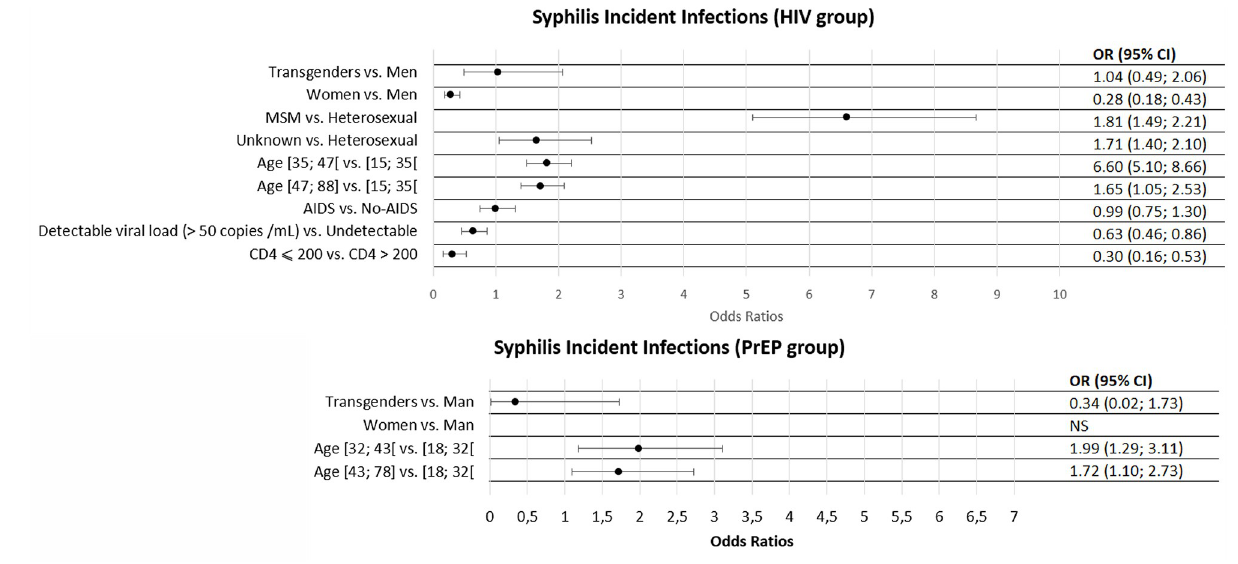
Fig 3. Adjusted odds ratios for factors associated with syphilis infection during follow up among